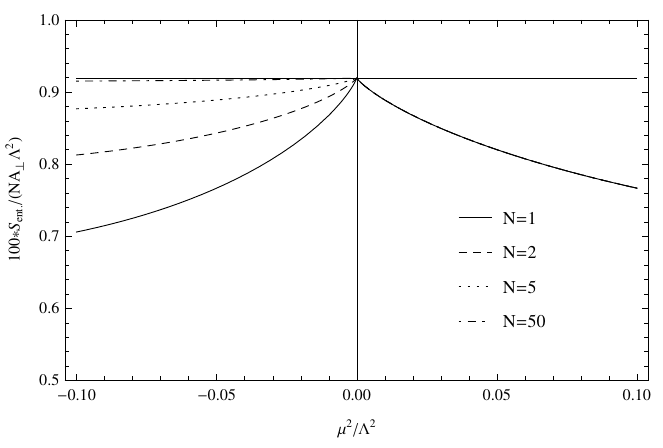
Figure 4 . Entanglement entropy of the O ( N ) σ -model in 3+1 dimensions, in units of NA ⊥ Λ 2 magnified by a factor of 100, against the mass squared of fields µ 2 normalized by Λ 2 . The left half ( µ 2 < 0 , with m 2 = − 2 µ 2 ) is the spontaneous symmetry broken phase while the right half ( µ 2 > 0 ) σ is the symmetric phase. In this plot, we take ˜ λ = 10 − 6 in order for the perturbation calculation to be valid. There is a cusped finite maximum at the quantum phase transition point µ 2 / Λ 2 = 0 .